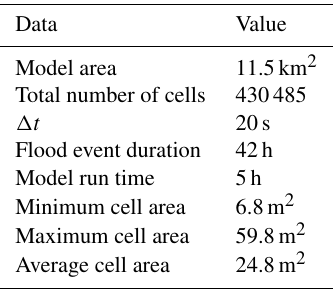
Figure 3. Discharge hydrographs at gauging stations upstream of the city, Ködnitz and Kauerndorf. RP stands for return period. Data source: Bavarian Hydrological Service (https://www.gkd.bayern. de/en/, last access: 27 March 2019). Table 2. The 2-D hydrodynamic model